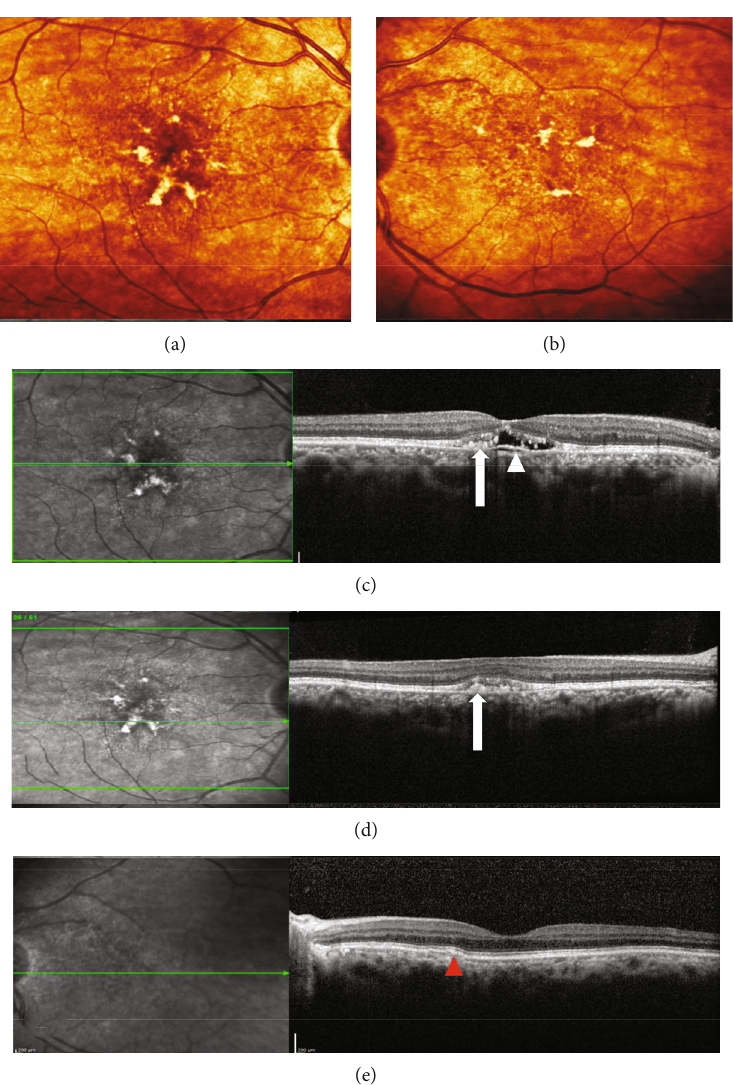
Figure 1: (a) and (b) Multicolour images (a) showing retinal pigment epithelial (RPE) alterations with vitelliform deposits in both macula simulating pattern dystrophy. Spectral-domain optical coherence tomography (SD-OCT) showing hyperre fl ective lesions in subretinal space ((c), (d) — arrows) with a shallow PED in the subfoveal region of the right eye ((c) — arrowhead) and similar deposition in the left eye (e) and focal extrafoveal DLS ((e) red arrowhead). Note the pachychoroid features in both